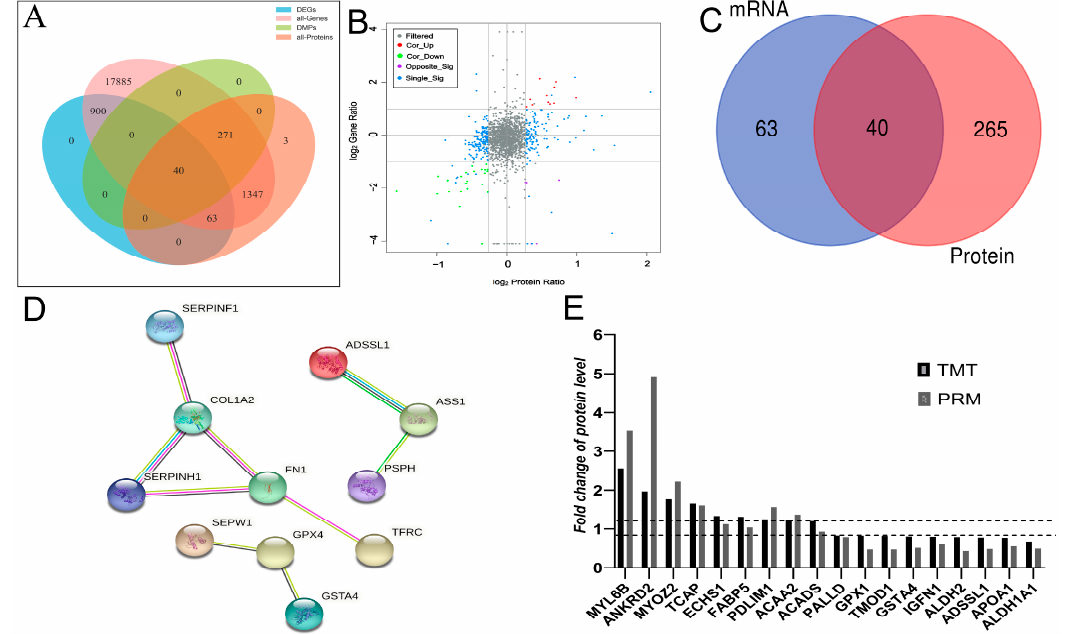
Figure 4. Correlation analysis of the DEGs and DAPs. ( A ) Venn diagram of all detected genes, DEGs, all detected proteins, and DAPs for Group G compared with Group HF ( B ) A correlation between transcripts ( y -axis) and proteins ( x -axis) in the Group G vs. Group HF comparison. Note: The ab- scissa is the log2 value of DAPS, and the ordinate is the log2 value of DEGs. Gray dots represent filtered non-differenced proteins (genes), and red dots (Cor-Up) represent differential proteins (genes) that are also upregulated. The green dots (Cor-Down) represent differentially expressed proteins (genes) simultaneously downregulated. The purple dots (Opposite_Sig) represent the DAPs (genes), which exhibited the opposite trend. The blue dots (Single_Sig) represent differential proteins (genes) that are differentially expressed at only one protein or mRNA level. ( C ) Venn dia- gram shows the overlap of DEGs and DMPs. ( D ) PPI analysis reveals the relationship between target DEGs and DAPs. ( E ) Validation of TMT by PRM analysis. 4. Discussion Yaks are raised in highly harsh environments all year round, and every year, there is a dry season period. However, the recent expansion of the yak population has severely degraded the grassland, and the growth performance of yaks has reduced significantly [19]. In our experiment, compared with the grazing group, the average daily gain and average net body weight of yaks in the HF group increased by 0.34 and 70.34 kg, respec- tively. The results showed that house-feeding could significantly improve the production performance of yaks and generate more economic benefits. The tenderness of meat is an essential indicator of the quality of meat products. It is a vital factor for evaluating meat quality by consumers and affects meat consumption. Tenderness is mainly determined by connective tissue content, followed by muscle fiber diameter, sarcoplasmic protein content, and intramuscular fat (IMF) content [20,21]. Yaks are grazed and maintained for a long period and slaughtered at an older age, which results in poor tenderness of yak meat and restricts its market acceptance. Many studies have shown that house feeding can improve the IMF content of LD muscle, reduce shear force, and improve the quality of yak meat [7,22]. Glycogen and lactic acid content in the muscle affect the muscle pH value. Therefore, pH is also among the crucial factors affecting meat